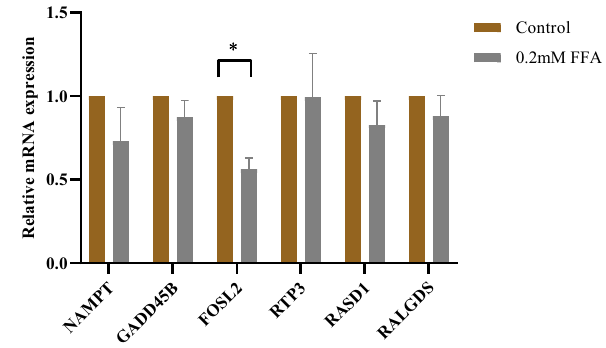
Figure 5: Relative expression of NAMPT, GADD45B, FOSL2, RTP3, RASD1, and RALGDS in QSG - 7011 cells with or without FFA ( * p < 0.05; mean ± SEM; n = 3 ) .